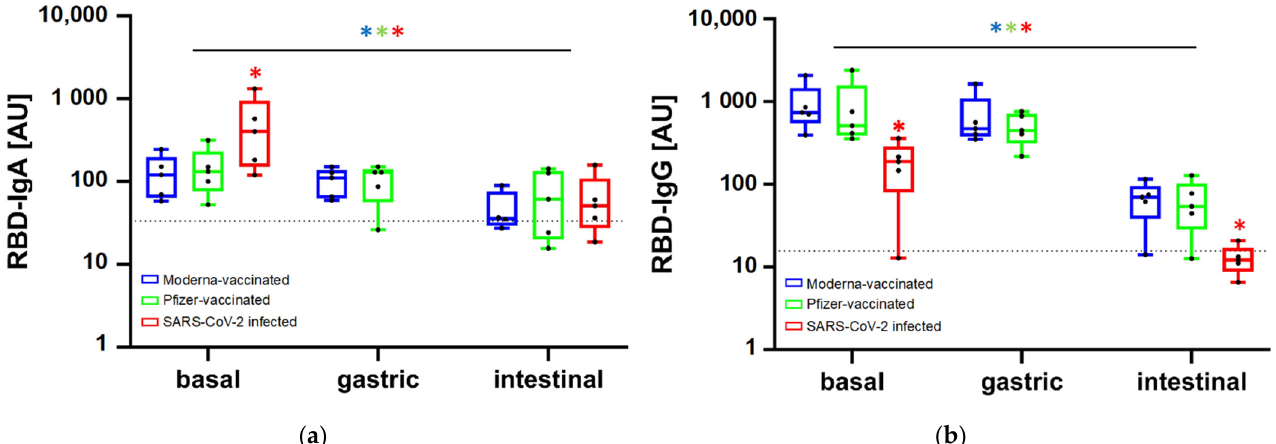
Figure 2. Change in anti-SARS-CoV-2 IgA ( a ) and IgG ( b ) levels along the simulated gastrointestinal digestion in the breast milk samples from the three study groups. In the SARS-CoV-2 infected group an aliquot at the gastric stage was not collected due to the scarce amount of sample. The horizontal dotted line indicates the cut-off value established as per pre-pandemic breast milk samples. * indicates statistically significant differences ( p < 0.05) between groups of samples within each timepoint and between time points considering each group of samples (blue * for Moderna-vaccinated, green * for Pfizer vaccinated and red * for SARS-CoV-2 infected).